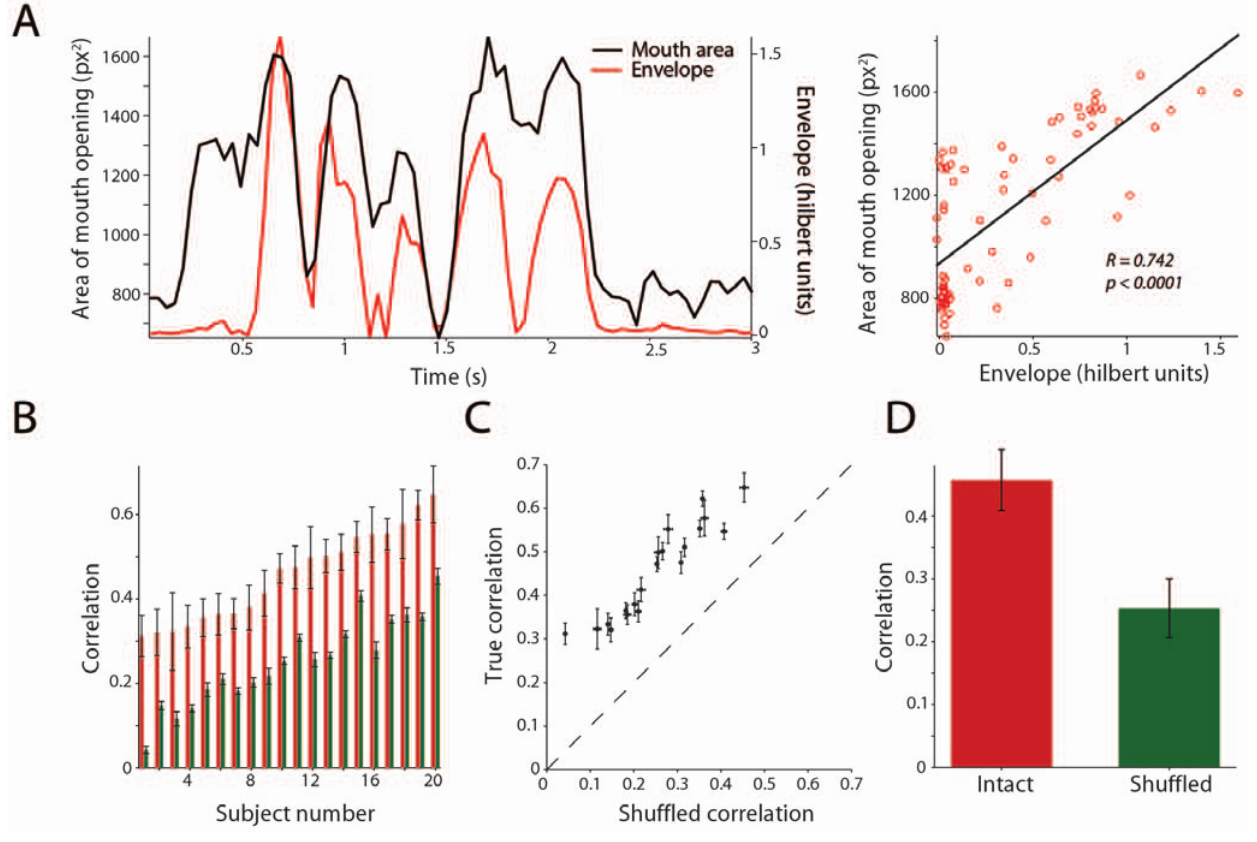
Figure 2. Average correlations between the area of the mouth opening and the audio envelope. A - Left, Area of the mouth opening and the auditory envelope for a single sentence from a single subject in the grid corpus as a function of time in seconds. X–axes depict time in seconds. Y–axes on the left depict the area of the mouth opening in pixel squared. Y-axes on the right depict the envelope in Hilbert units. Right, scatter plot of the envelope and area of the mouth opening along with the corresponding regression line. Each red circle denotes a single point in the speech time series. Black line denotes the linear regression between the area of the mouth opening and the envelope power. Correlation coefficient between auditory and visual components for this sentence was 0.742 (p , 0.0001). B - Average rank ordered intact correlations (red bars) and shuffled correlations (green bars) for the 20 subjects analyzed in the GRID corpus. X-axes depict subject number; Y- axes depict the correlations. Intact correlations for each subject were the average across all sentences analyzed for that subject. Error bars denote standard error of the mean. Shuffled correlations were computed as an average correlation between all non paired auditory envelopes and the mouth area function for each subject. C - Scatter plot of the average intact versus the average shuffled correlations for the 20 subjects in the dataset. Mean intact and shuffled correlations over the 20 subjects in the GRID corpus. Error bars denote standard error of the mean.